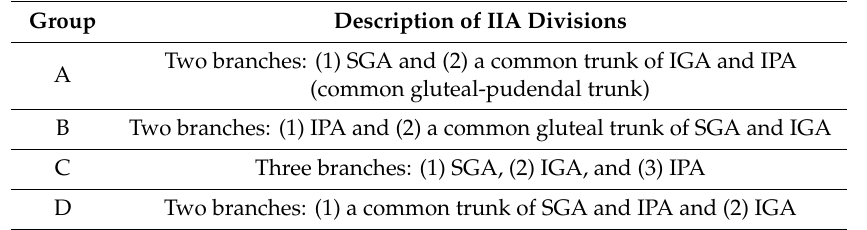
Table 1. Yamaki et al. (1998) [26] IIA branching pattern classification system. SGA = superior gluteal